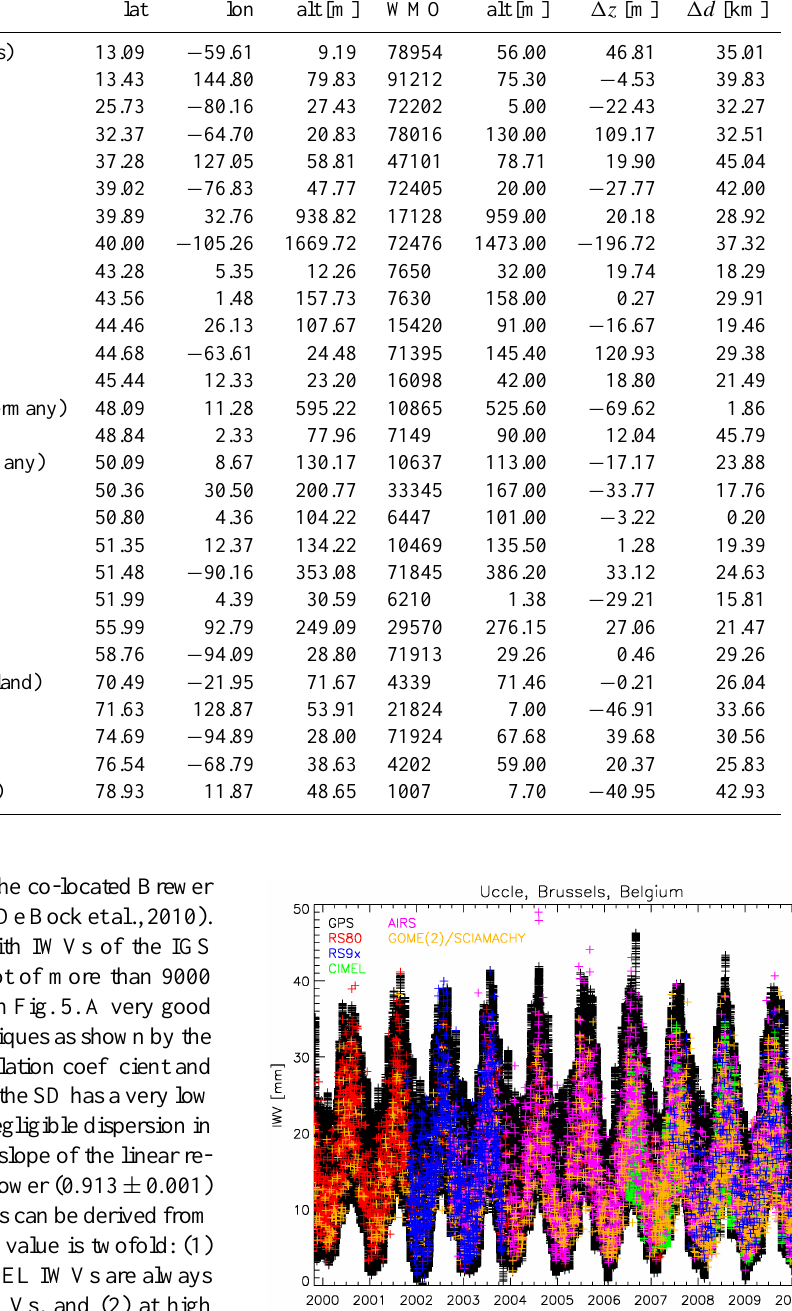
Table 4. List of the selected IGS stations, with latitude, longitude and altitude and the used WMO meteorological station to convert the ZTD to IWV. The latter 3 columns represent the WMO station height and the vertical and horizontal distances between the IGS and WMO station. IGS